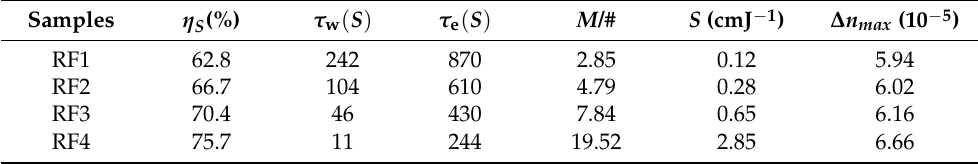
Table 4. The blue ( λ = 476 nm) photorefractive properties of Sc:Ru:Fe:LiNbO 3 crystal.